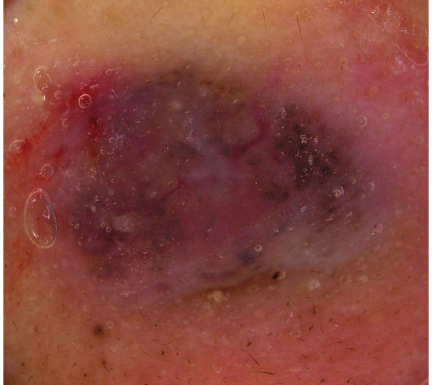
Figure 5: Dermatoscopic examination showed multiple blue/gray globules and arborizing telangiectasia, lacking a homogenous blue/black